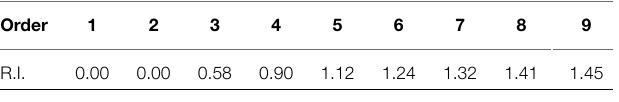
TABLE 3 | Stochastic index table.